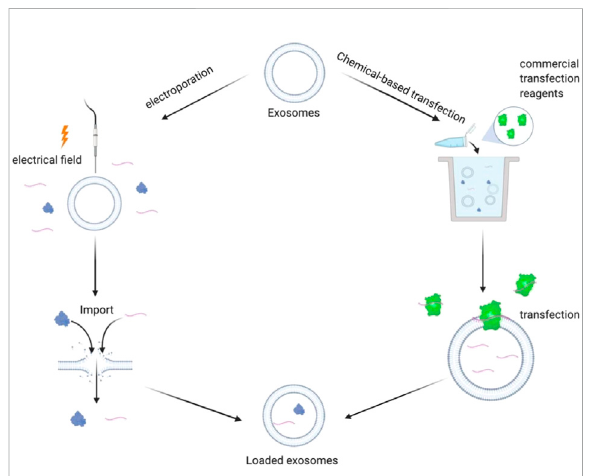
FIGURE 2 Schematic diagram of exogenous drug loading principle: electroporationmethod:undertheactionofexternalelectric fi eld, the phospholipid bilayer produces repairable pores, and the drug enters the exosomes through the holes. Chemical transfection: under the action of commercial transfection agent, exogenous drugs enter the